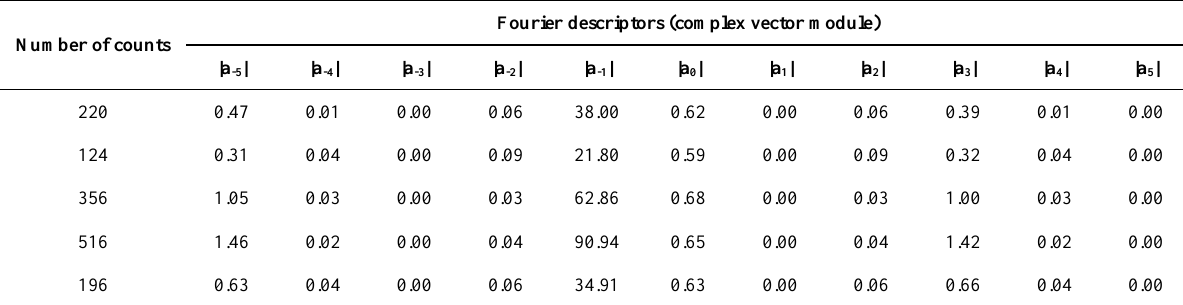
Table 1. Fourier descriptors of contours of different sizes